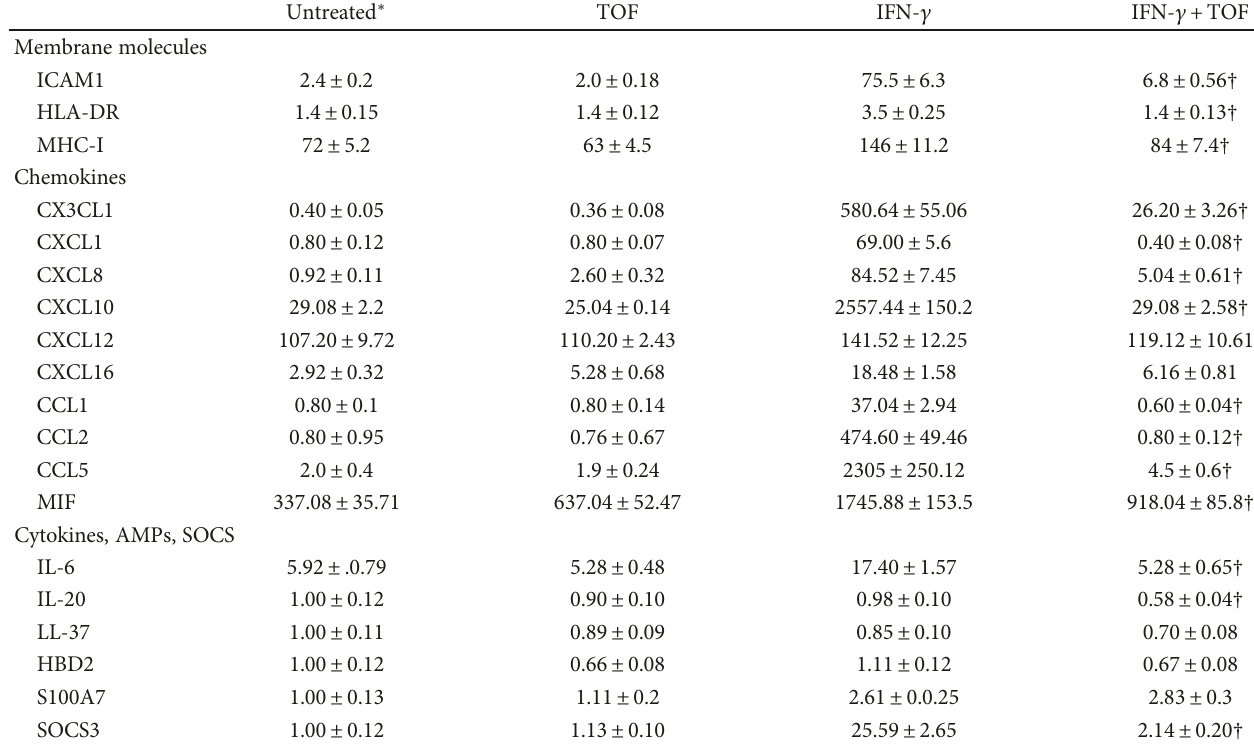
Table 1: Tofacitinib e ff ects on the expression of in fl ammatory molecules induced by IFN- γ in